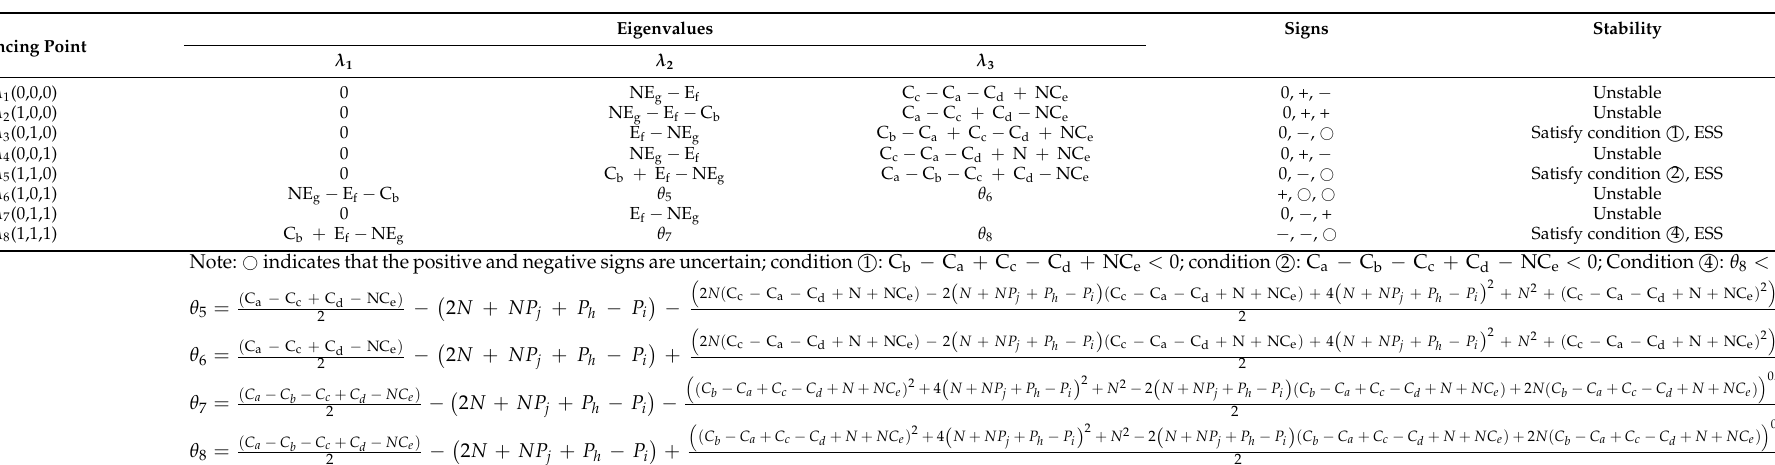
Table 7. Strategic Portfolio Stability Analysis under Miner Optimistic, Government and SMEE Rational